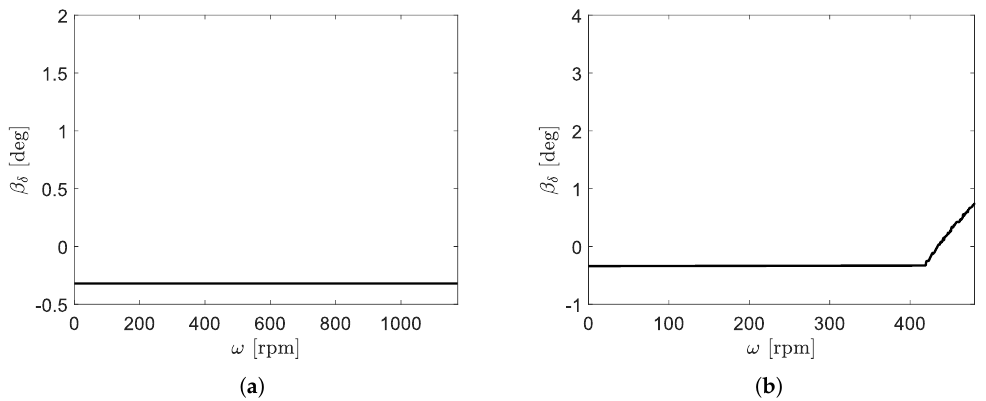
Figure 6. Optimal minimum pitch angle as a function of generator speed for NREL 5-MW ( a ) and DTU 10-MW ( b ) reference turbines. ( ω ) look-up Algorithm 2 Calculate the β opt | λ